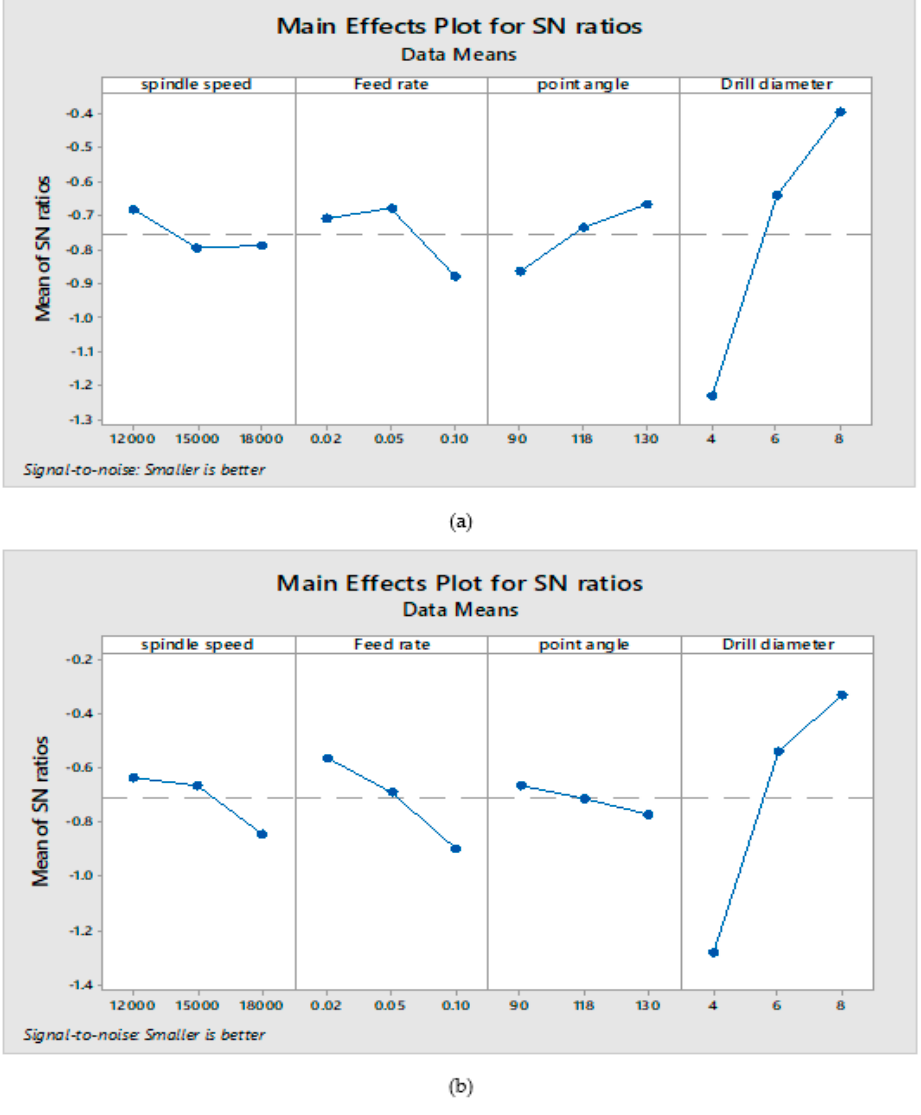
Figure 5. Main effects plots for S/N ratios of ( a ) Peel-up delamination and ( b ) Pushout